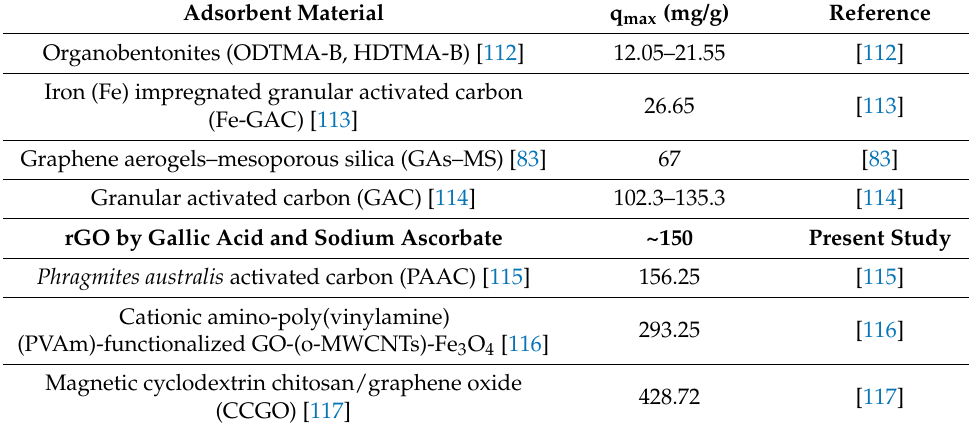
Table 5. Comparison of adsorption capacity of HQ ( q max , mg/g) of rGO with other graphene